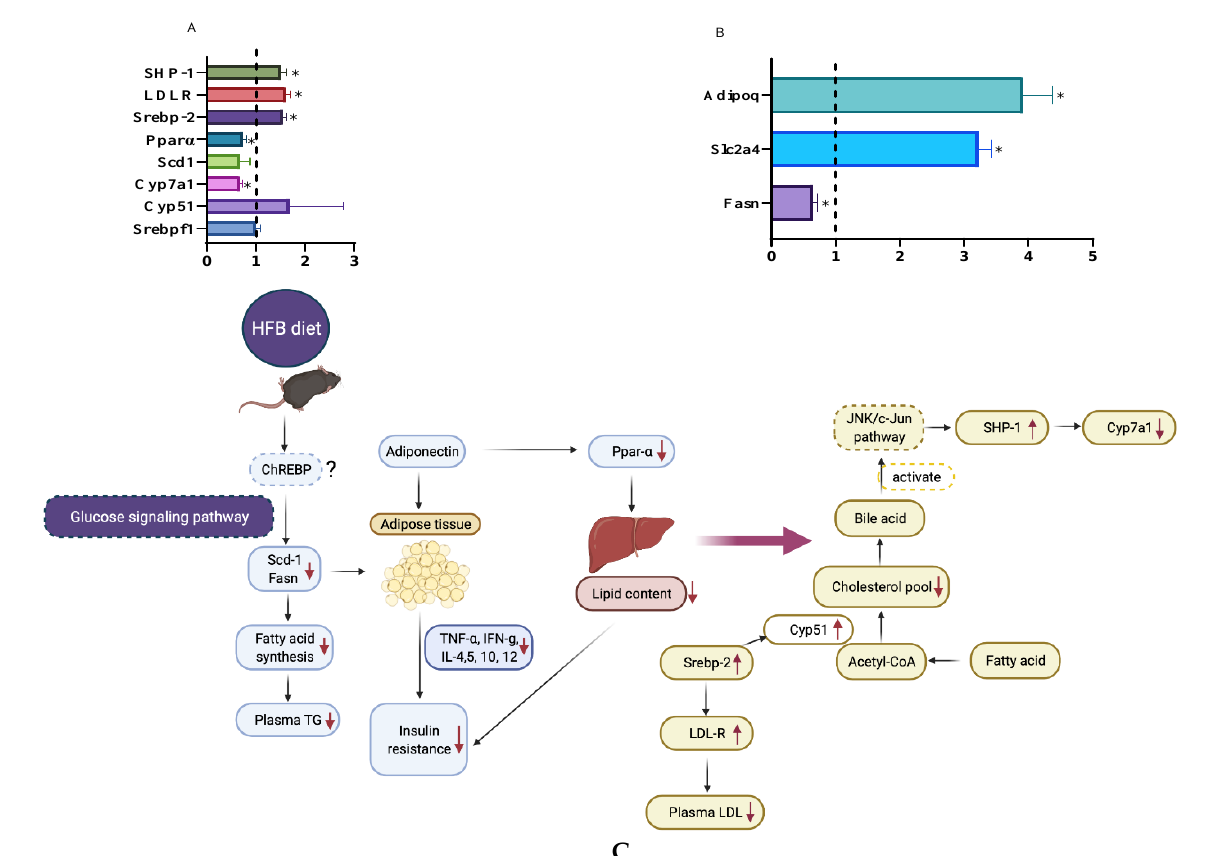
Figure 5. Relative hepatic gene expression of Srebf1 , Cyp51 , Cyp7a1 , Scd1 , Ppara , Screbp-2 , and LDL-R in mice fed HFQ diet compared to HF diet ( A ). Relative expression of Fasn , Slc2a4 and Adipoq genes in epididymal adipose tissue of mice fed HFQ diet compared to HF diet ( B ). Data are expressed as mean ± SEs, and n = 4/group. Differences in mRNA expression for livers and adipose were calculated after normalizing to 35B4 mRNA expression. Asterisk indicates significant difference ( p < 0.05). Dotted line (x = 1) represents the expression of control gene. ( C ) Proposed mechanism responsible for ameliorating insulin resistance in mice fed HF diet supplemented with cooked black turtle beans, glucose signaling pathway, JNK/c-Jun pathway and ChREBP (dashes outline) were extrapolated from literature